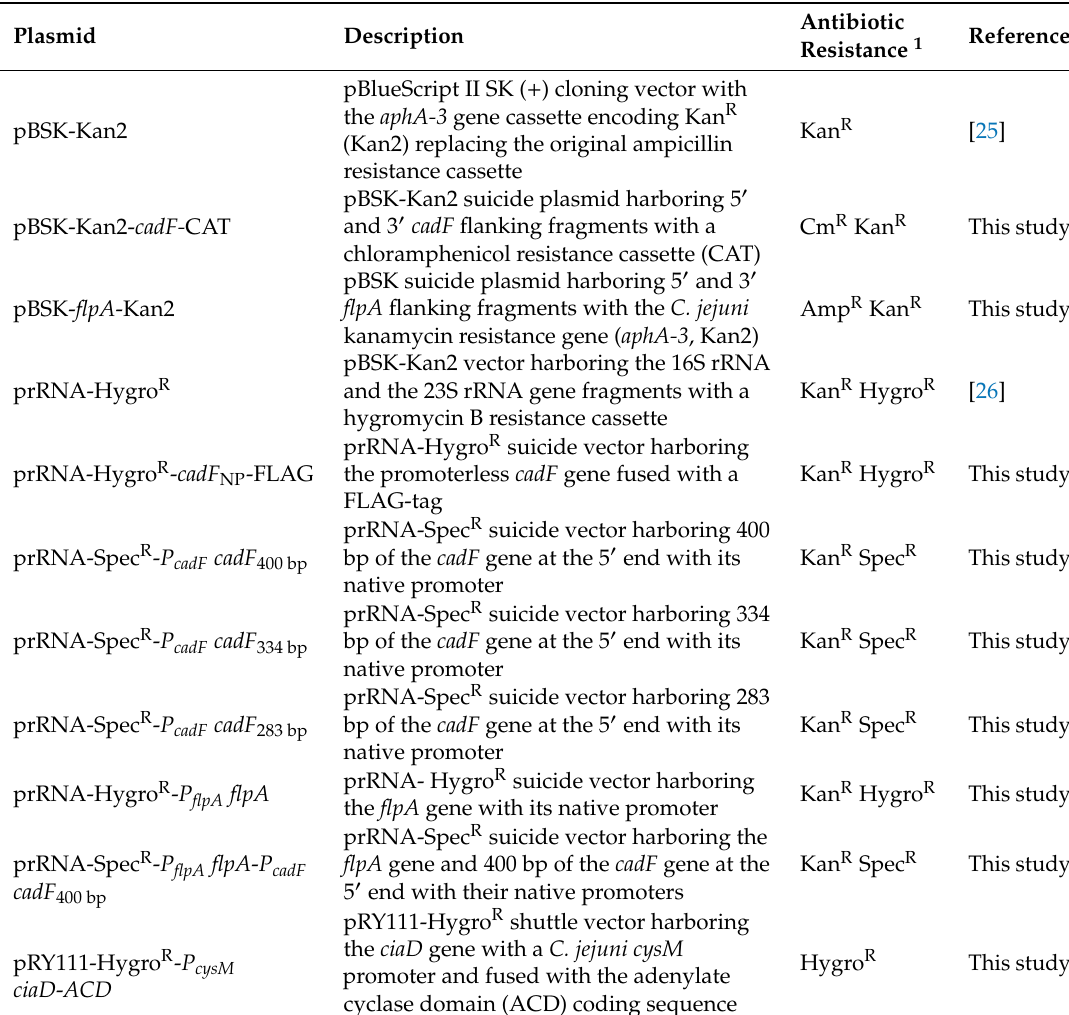
Table 2. Bacterial plasmids used in this